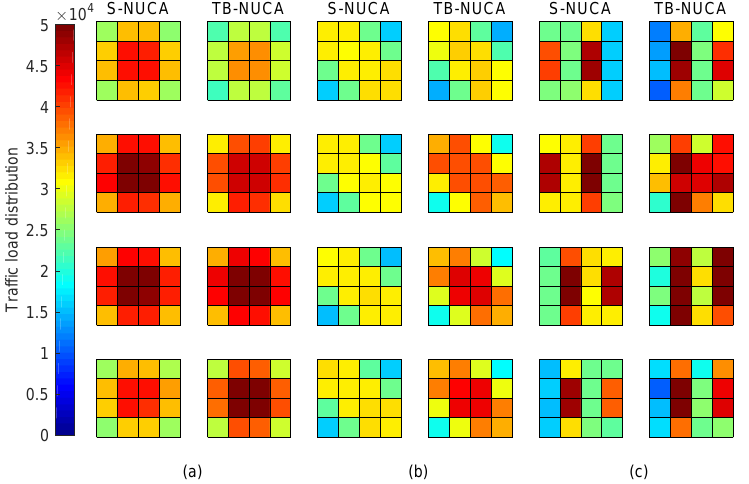
Figure 8. Traffic load distribution comparison under different traffic conditions: ( a ) Random. ( b ) Transpose-2. ( c ) Shuffle. In TB-NUCA mapping, the traffic load of the lower layer increases, which leads to se- rious traffic congestion in the lower layer. Throughput can be affected by traffic